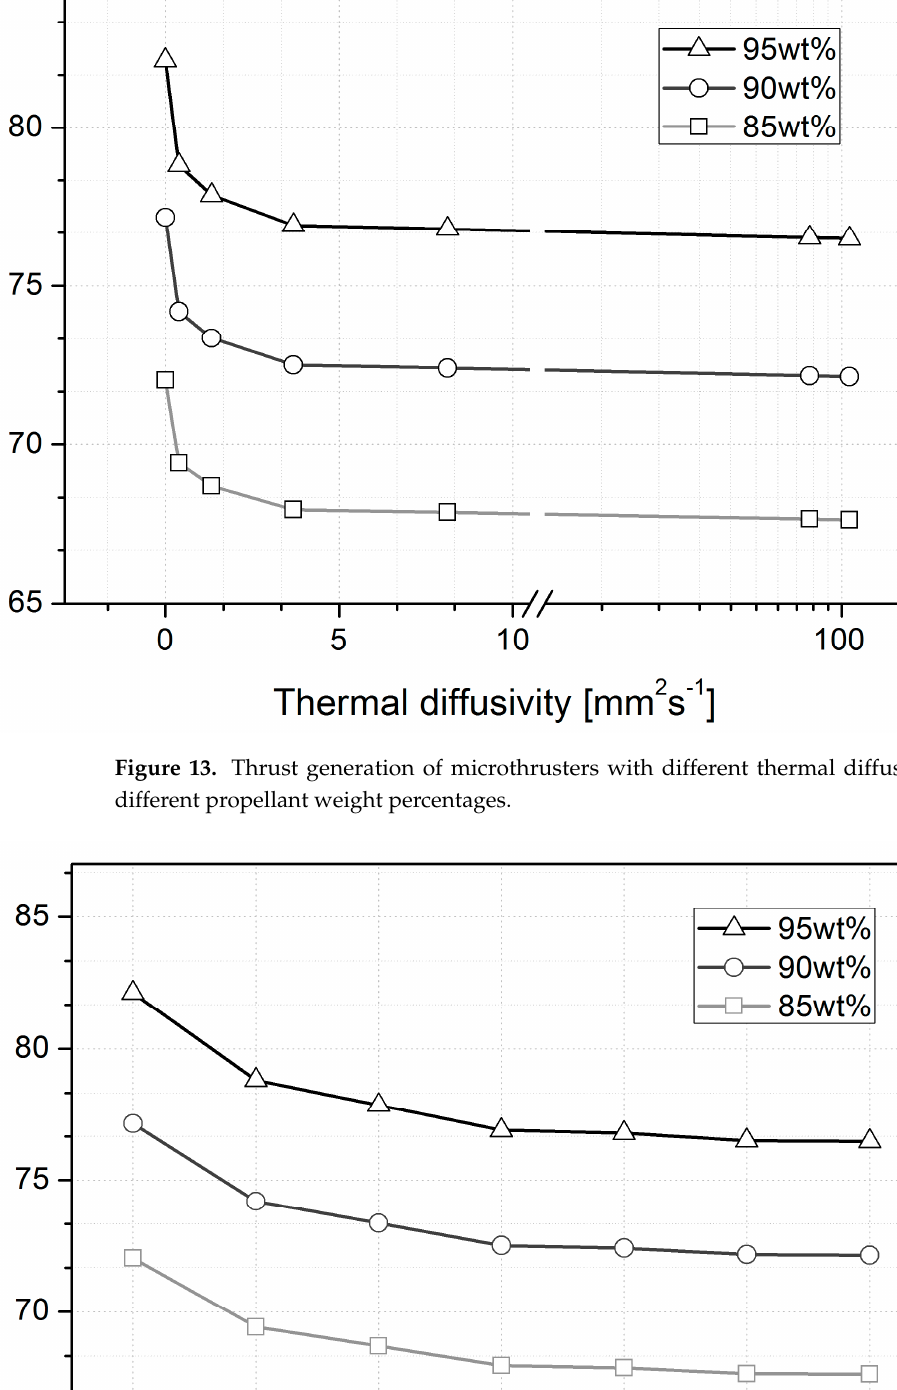
Figure 12. Chamber pressure of microthrusters with different thermal diffusivity materials and dif- ferent propellant weight percentages (mass flow rate of 7 × 10 − 5 kg/s).